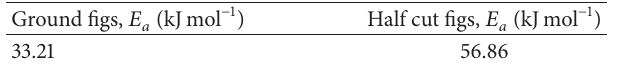
Table 2: Activation energy ( 𝐸 𝑎 ) for dehydrated ground figs and half cut figs. Ground figs, 𝐸 𝑎 (kJmol − 1 ) Half cut figs, 𝐸 𝑎 (kJmol − 1 ) 33.21